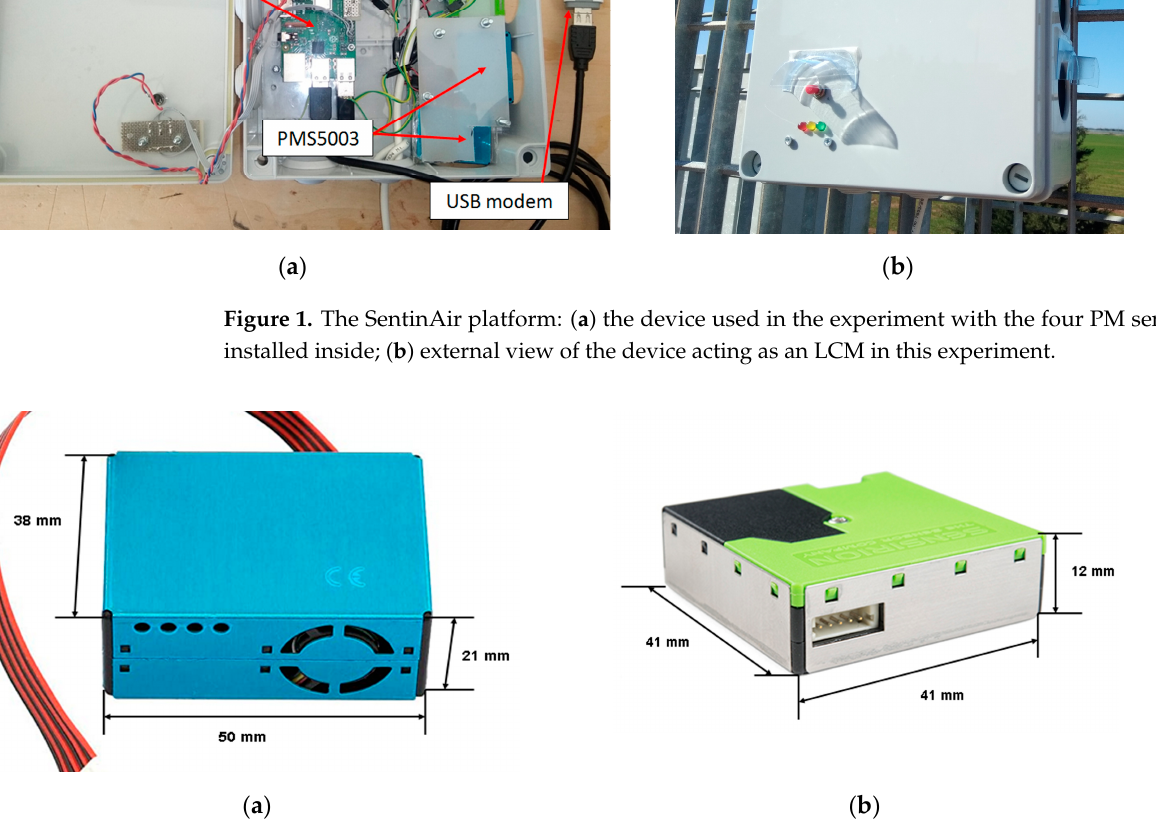
Figure 2. The miniaturized sensors used in this study: ( a ) the PMS5003 produced by Plantower and its size; ( b ) the SPS30 produced by Sensirion and its size.